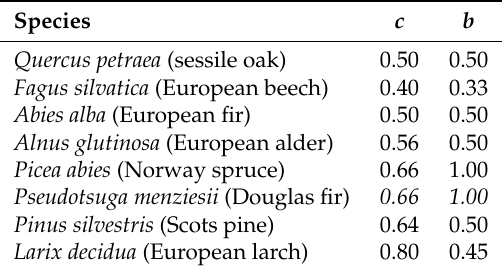
Table 2. Tree species-specific light crown model parameters according to Pretzsch [41]. Values indicated in italics were based on assumption, since they were not given by Pretzsch [41]. Reproduced with permission from Eugen Ulmer Verlag,